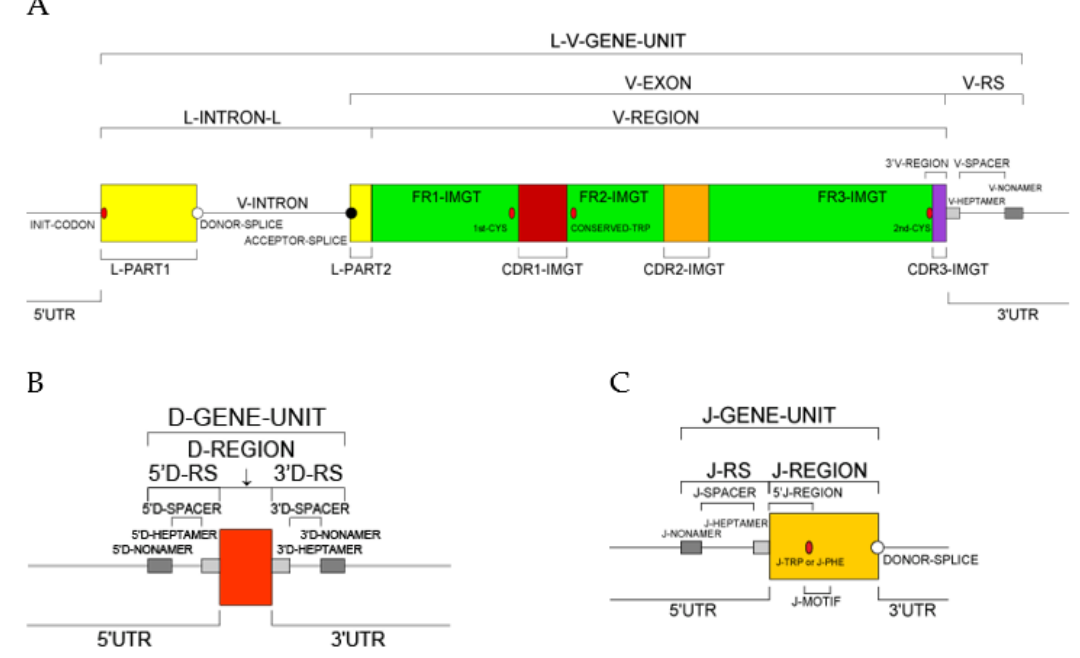
Figure 2. Prototypes with IMGT standardized labels. ( A ) L ‐ V ‐ GENE ‐ UNIT. This label describes gDNA of an IG or TR V ‐ GENE unit, in germline configuration, that comprises L ‐ PART1, V ‐ INTRON, V ‐ EXON and V ‐ RS. ( B ) D ‐ GENE ‐ UNIT. This label describes gDNA of an IG or TR D ‐ GENE unit, in germline configuration, that comprises 5 ′ D ‐ RS, D ‐ REGION and 3 ′ D ‐ RS. ( C ) J ‐ GENE ‐ UNIT. This label describes gDNA of an IG or TR J ‐ GENE unit, in germline configuration, that comprises 5 ′ J ‐ RS and J ‐ REGION. Definitions of the IMGT standardized labels are available at https://www.imgt.org/ligmdb/label# (accessed on 22 February 2022). Abbreviations: L: leader, RS: recombination signal (With permission from M ‐ P. Lefranc and G. Lefranc, LIGM, Founders and Authors of IMGT ® , the international ImMunoGeneTics information system ® ).